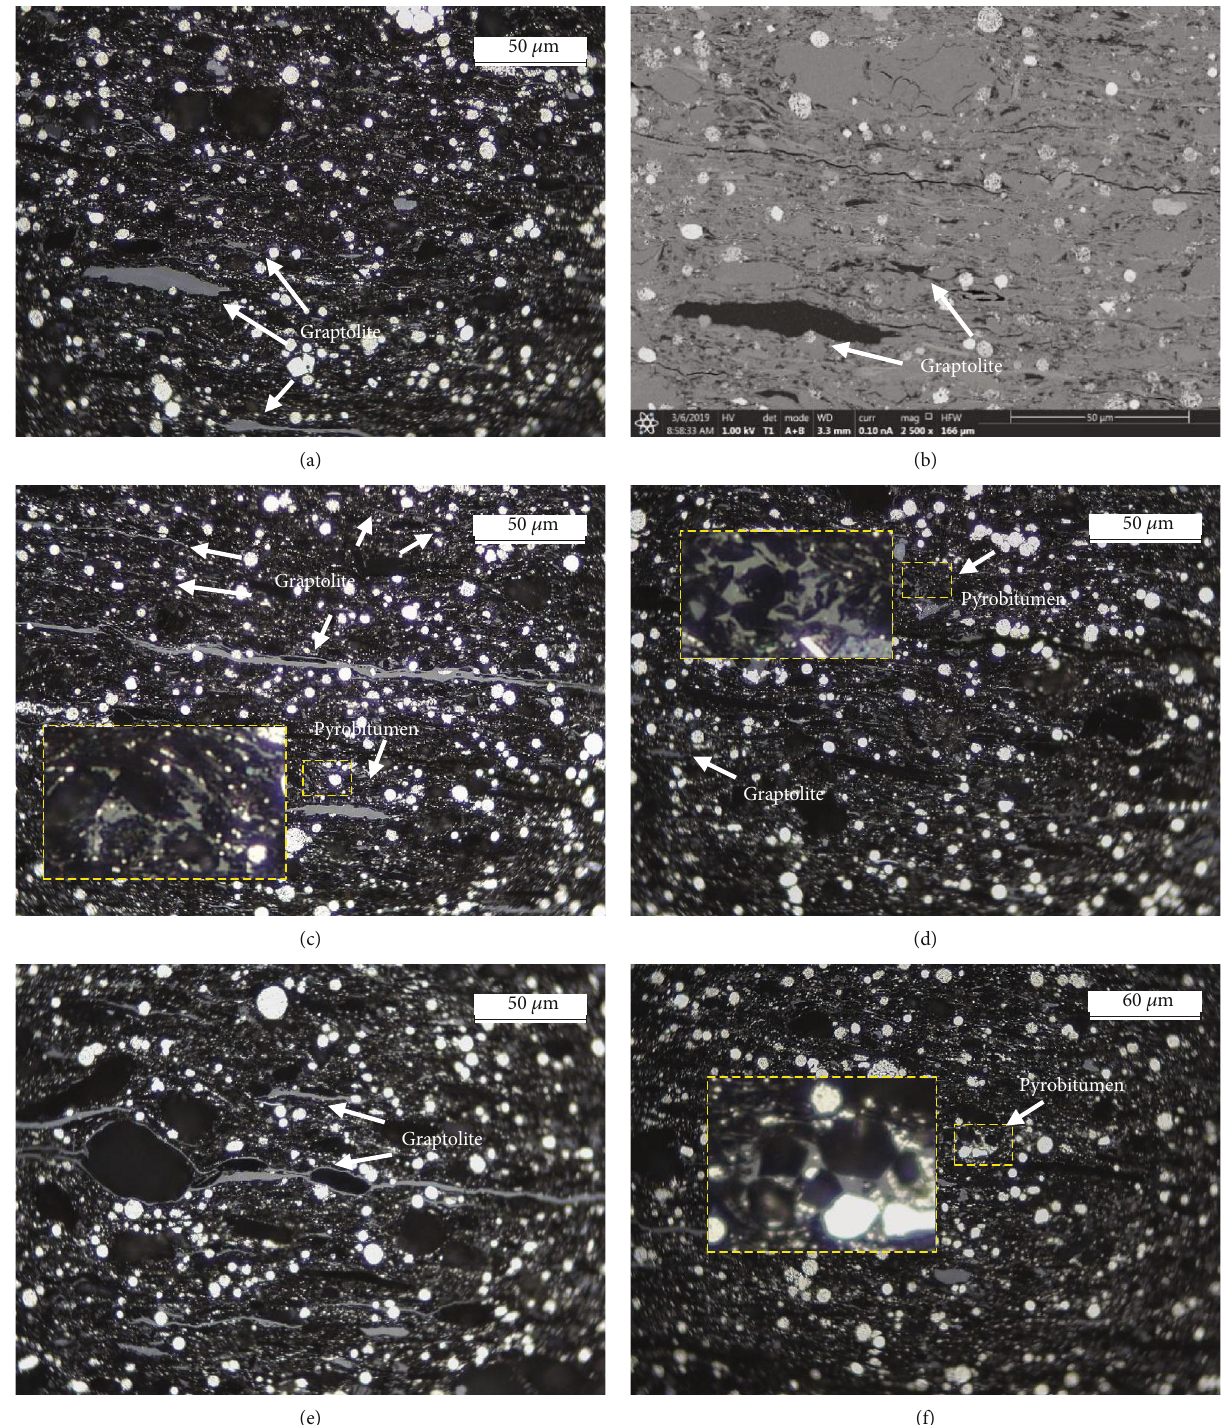
Figure 7: Organic petrography photomicrographs (oil immersion, white incident light) (a, c – f) and SEM images (b) showing typical maceral types (graptolite and pyrobitumen) and distributions of sample TRA-10. (a, b) The microscopy (a) and SEM (b) analysis on the same area of TRA-10. The larger rectangles in (c, d, f) are enlarged areas of the related smaller rectangles. (a, b) Typical graptolite grains occurred as large pieces and oriented in a direction parallel to the bedding plane. (c, d, f) Thinner graptolite pieces dispersed within the shale matrix. (c – f) Small pyrobitumen (less than a few micrometers) grains fi lled in minerals and oriented in various directions. (e) Some graptolites of a spindle or lenticular